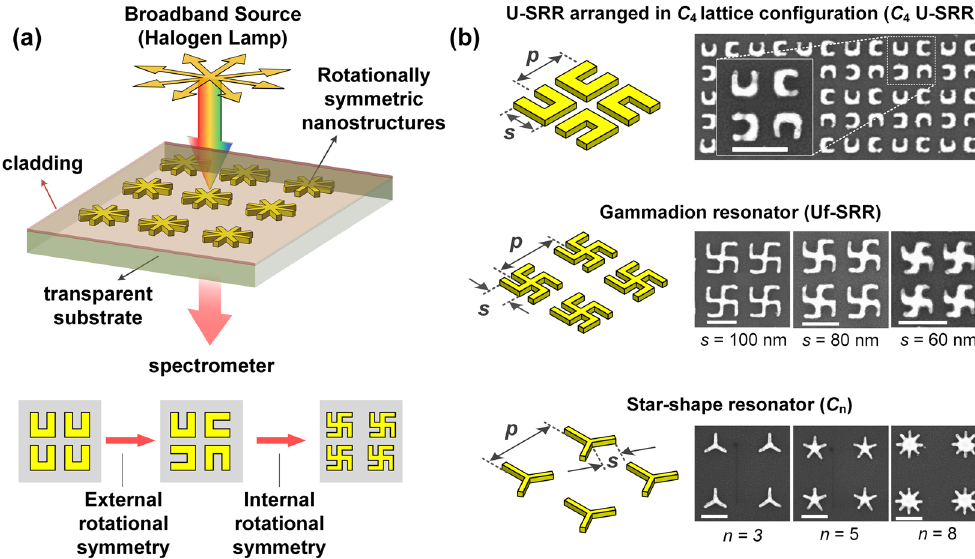
Figure 1. Incorporating rotational symmetry for making robust plasmonic sensing platform. ( a ) Schematic of polarization-invariant sensing platform based on unpolarised broadband light source and rotationally symmetric metal nanostructures. ( b ) Plasmonic nanostructures with varying rotational symmetry. (Top) U-SRRs in C 4 lattice configuration with the periodicity normalized to resonator size, i.e., p = 2 s . The unit cell is denoted by the dashed line. (Middle) Gammadion structures with periodicity ( p ) normalized to their arm lengths ( s ), i.e., p = 3 s . (Bottom) Star-shape structures with different rotational symmetry at fixed periodicity of p = 400 nm and arm length of s = 100 nm. Both the gammadion and star-shaped nanostructure are in square lattice configuration. All scale bars represent 200